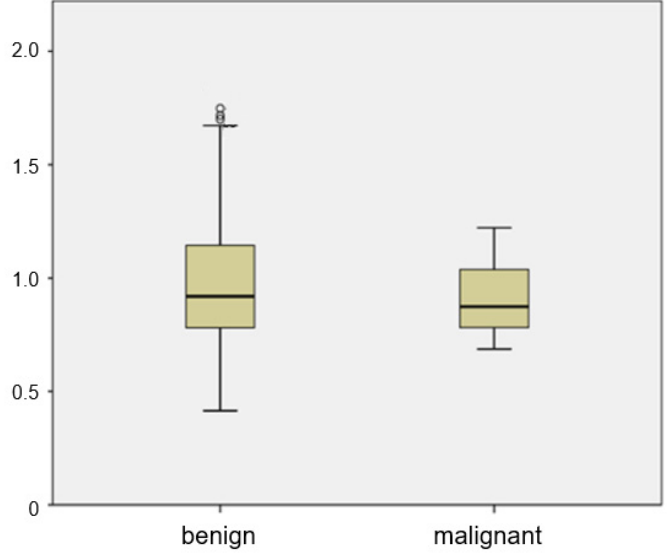
Figure 3. Box plot of mean ADCs of benign and metastatic ALNs. The top and bottom of each box represent the 25th and 75th percentiles of the ADC, respectively. The horizontal line inside each box represents mean value.